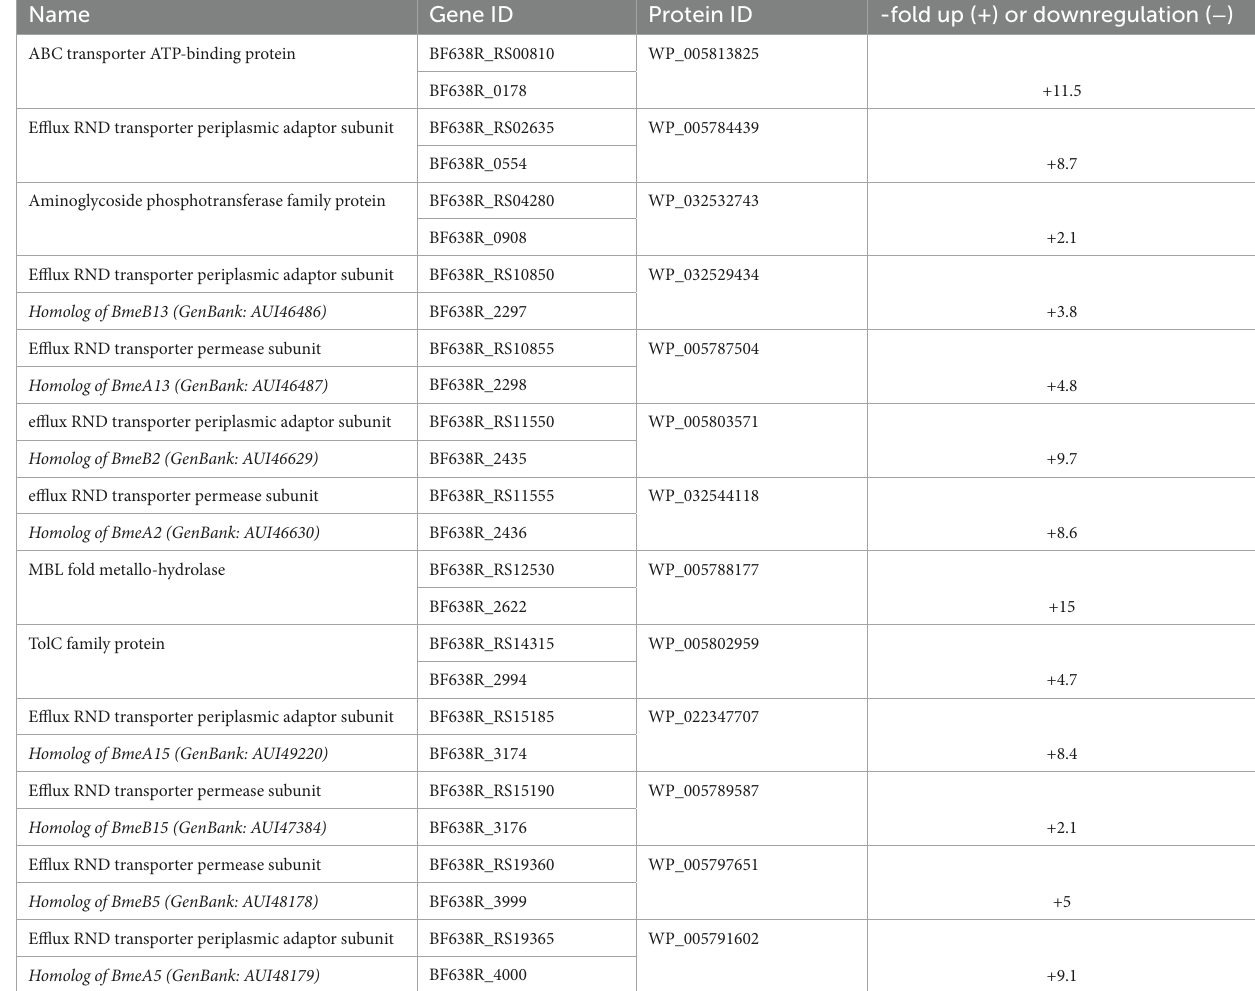
TABLE 4 Putative antibiotic resistance factors differentially expressed in 638R R vs.